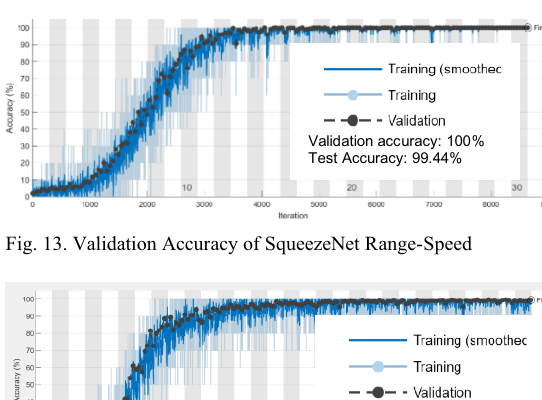
TABLE IX. PERFORMANCE OF S QUEEZE N ET IN A CLEAN ENVIRONMENT Category Car Truck Motocycle Range- Validation 100% 100% 100% angle accuracy Accuracy 98.33% 99.1667% Range- Validation doppler accuracy